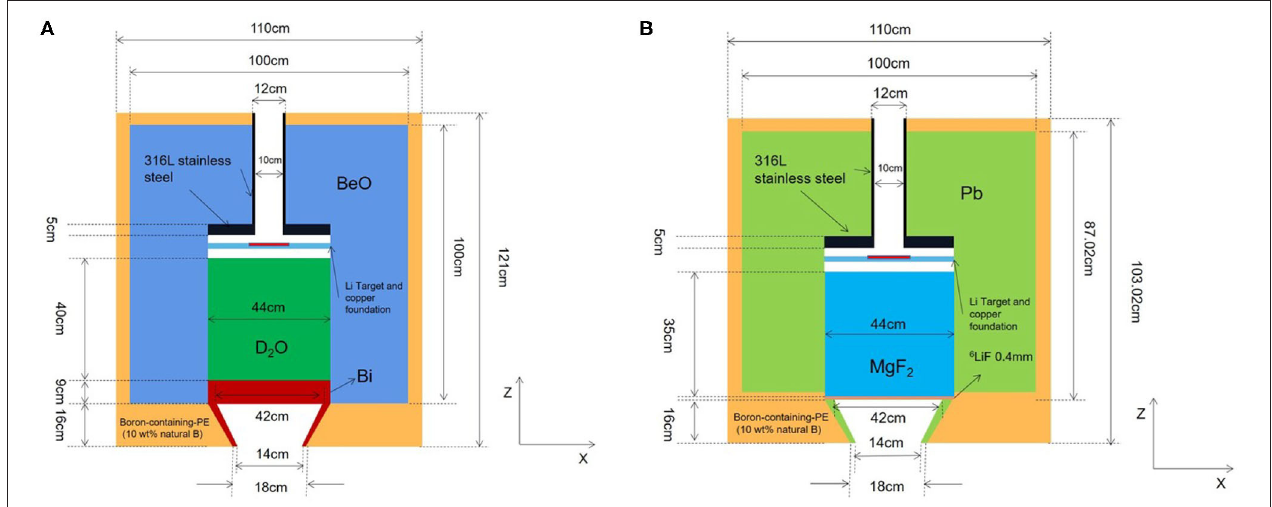
FIGURE 7 | Structures of proposed epithermal and thermal neutron beam BSAs, (A) is thermal neutron BSA, and (B) is epithermal neutron BSA.